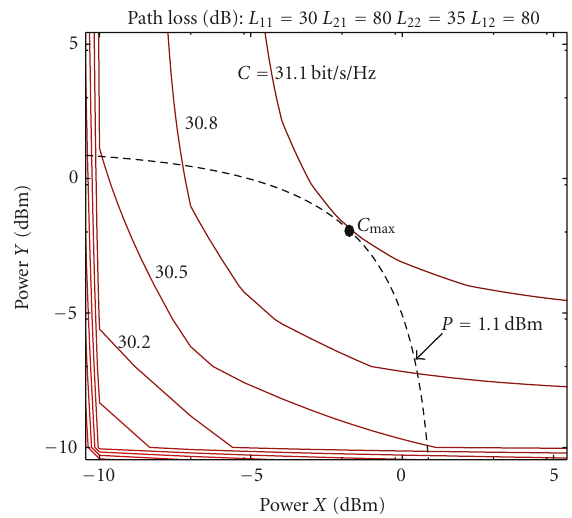
Figure 4: Contour plot of the system spectral e ffi ciency over the power domain ( x , y ). The dashed line depicts the spectral e ffi ciency for constant power P = 1 . 1